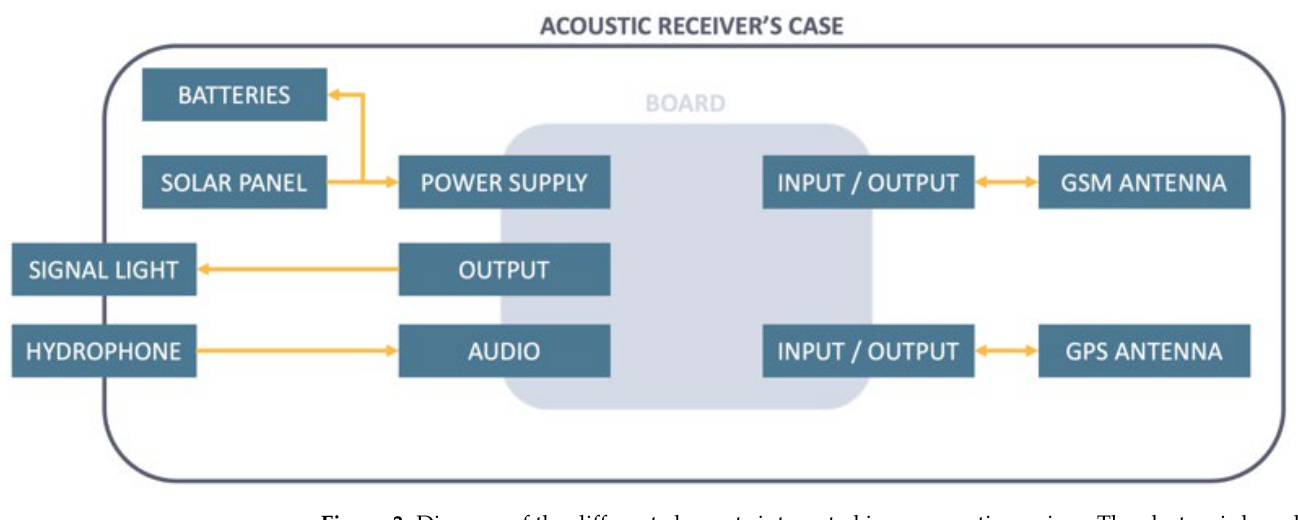
Figure 3. Diagram of the different elements integrated in an acoustic receiver. The electronic board, located in the center in grey, is enclosed in a waterproof case and linked to its peripherals by waterproof connectors. It is responsible for processing the signal from an acoustic transmitter and sending the data to the server. The solar panel, batteries and both GPS and GSM antennas are located inside the acoustic receiver case, while the hydrophone and the signal light are located